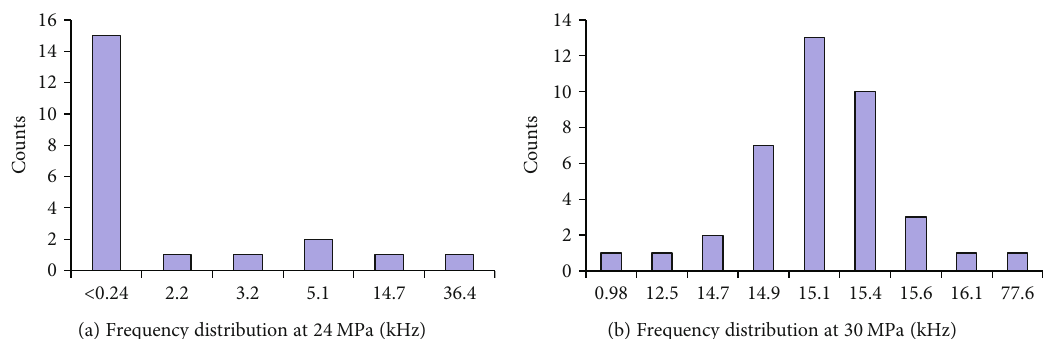
Figure 9: The main frequency distribution of acoustic signal: (a) 26MPa; (b) 32 MPa.